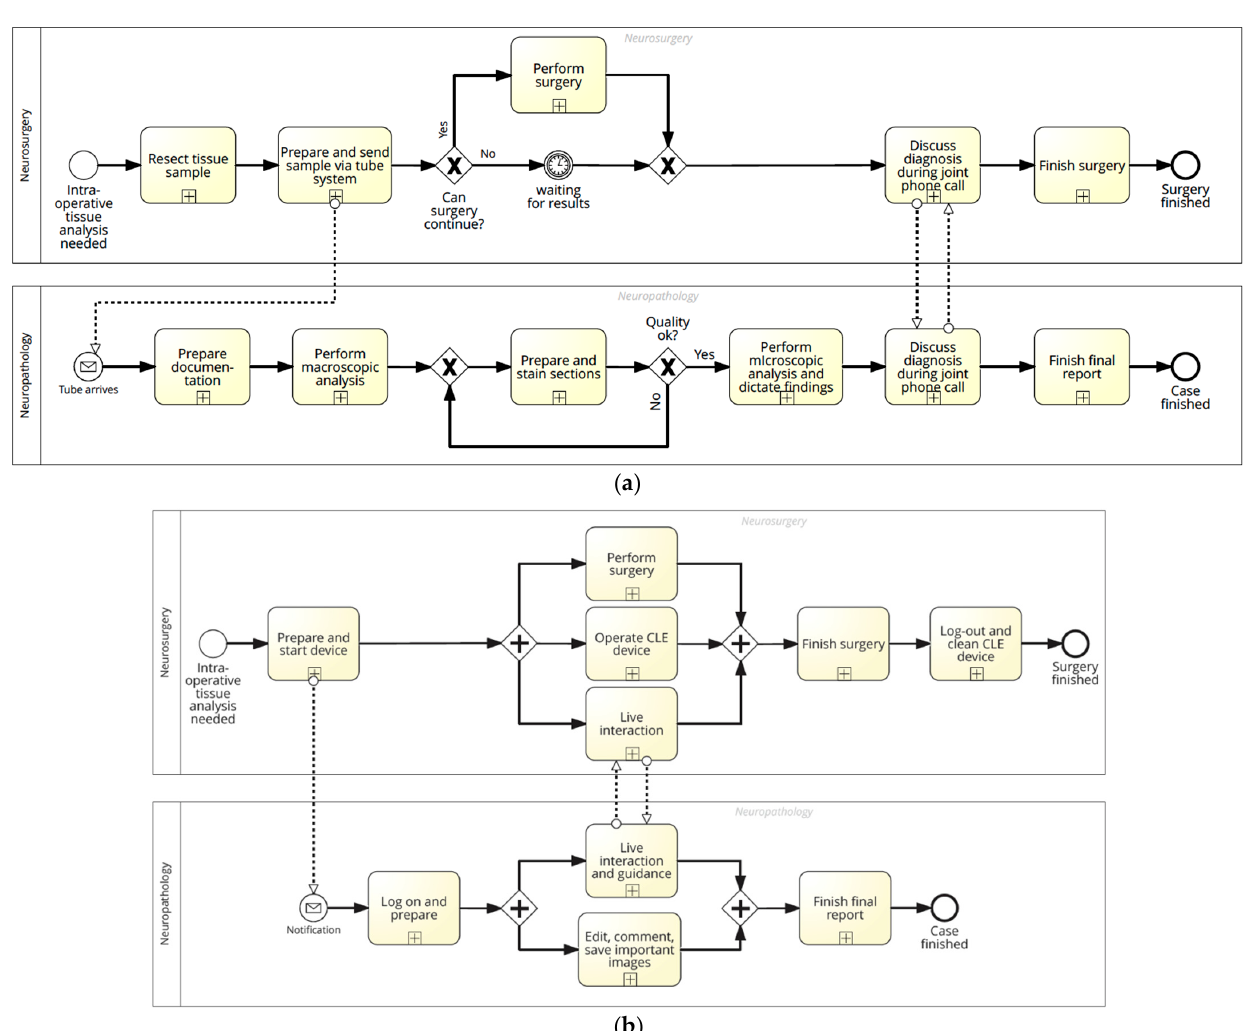
Figure 1. Simplified versions of the two processes: ( a ) Current process of frozen section analysis; ( b ) Digitized process using CLE. Circles mark the start and end of the process, arrows show the process flow, rectangles represent tasks, tasks with the “+” indicate collapsed subprocesses, the diamond with the “×” represents an exclusive gateway (XOR), meaning only one path continues, and the diamond with the “+” denotes a parallel gateway (AND), meaning all paths continue.